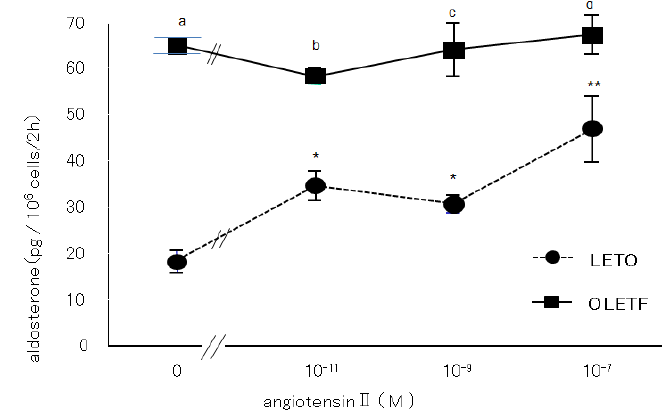
Figure 4. Effect of losartan on basal aldosterone production by rat AoSMC. Rat AoSMC were incubated with or without 10 − 5 M losartan for 2 h, and then the culture media had their aldosterone concentrations determined, as described in the text. Data are presented as the mean of three different experiments. Each experiment was performed in